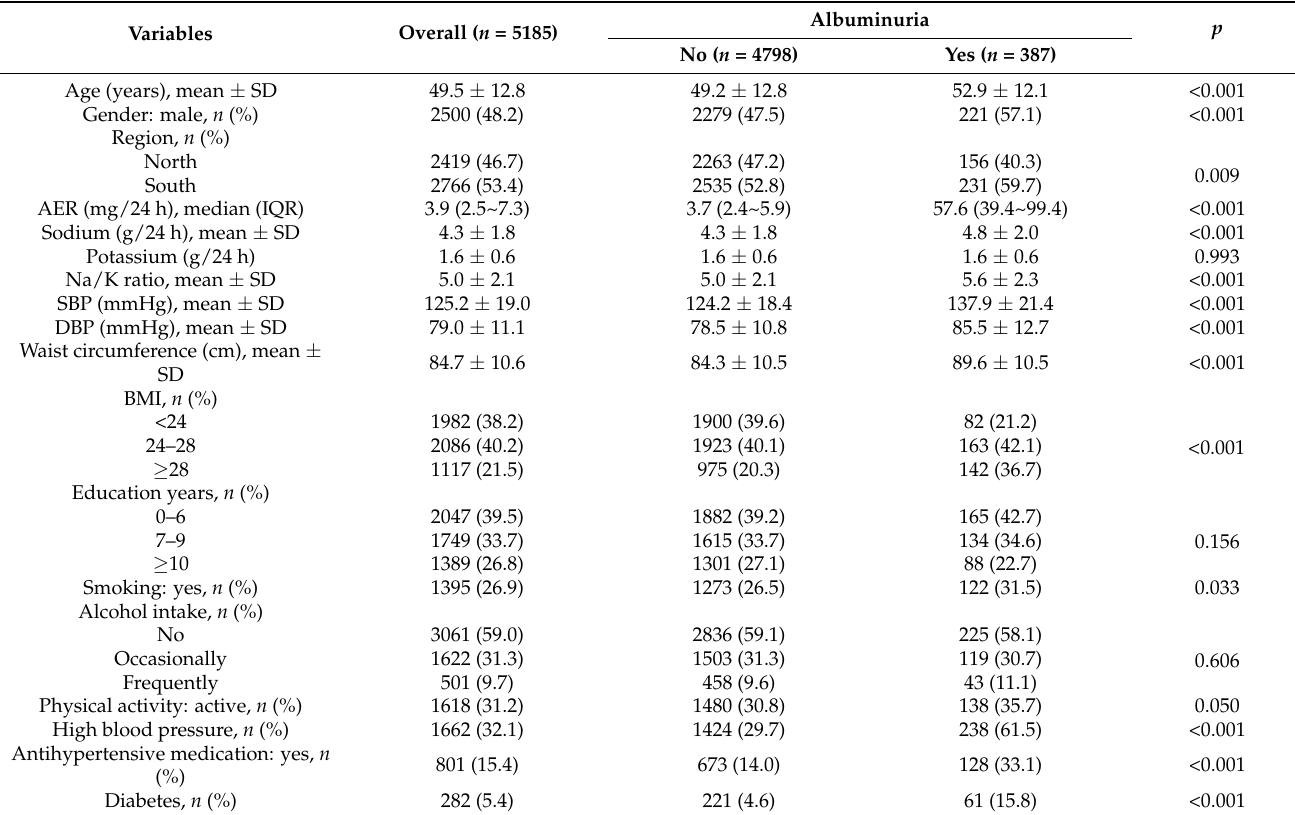
Table 1. Characteristics of participants in the ASC study by the presence of albuminuria.